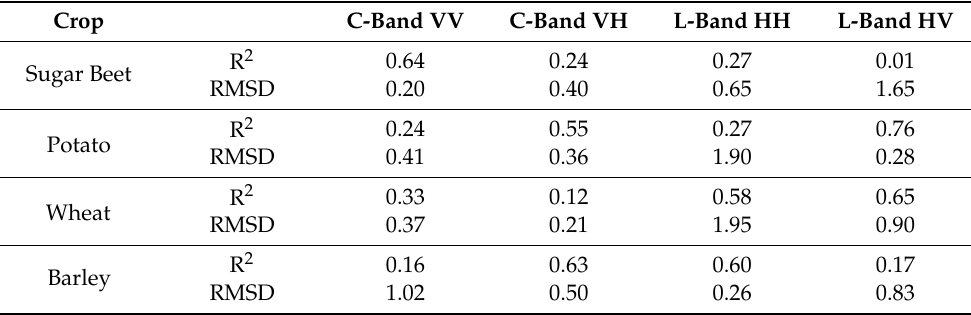
Table 5. R 2 and RMSD of the linear regression between backscattering signal and vegetation water content (VWC).